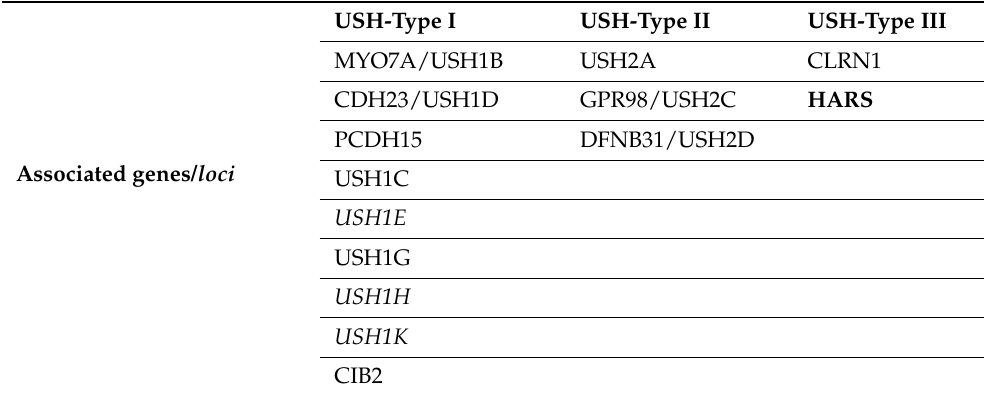
Table 3. Genes and loci associated with Usher syndrome. Loci are denoted in italics.